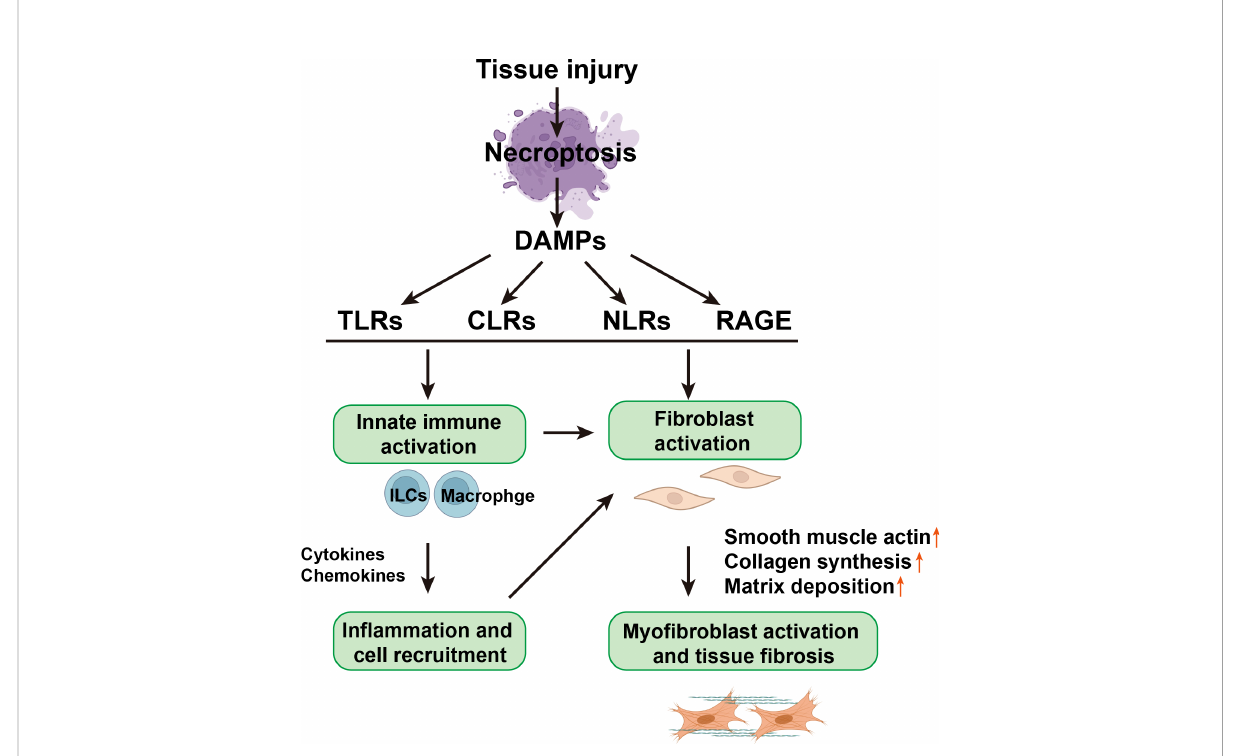
FIGURE 2 The relationship between necroptotic DAMPs, in fl ammation, and fi brosis. Necroptotic DAMPs can initiate immune responses and pro fi brotic responses of nonimmune cells, such as epithelial cells, endothelial cells, and fi broblasts, through the activation of PRRs, which include TLRs, CLRs, and NLRs. Necroptotic DAMPs can also be sensed by non-PRR DAMP receptors, such as RAGE. On the one hand, DAMPs can directly activate fi broblasts and then activate myo fi broblasts, directly causing tissue fi brosis; on the other hand, DAMPs stimulate innate immune cells, such as innate lymphoid cells (ILCs) and macrophages, to secrete cytokines and chemical factors, thereby triggering cell recruitment and in fl ammation and further activating fi